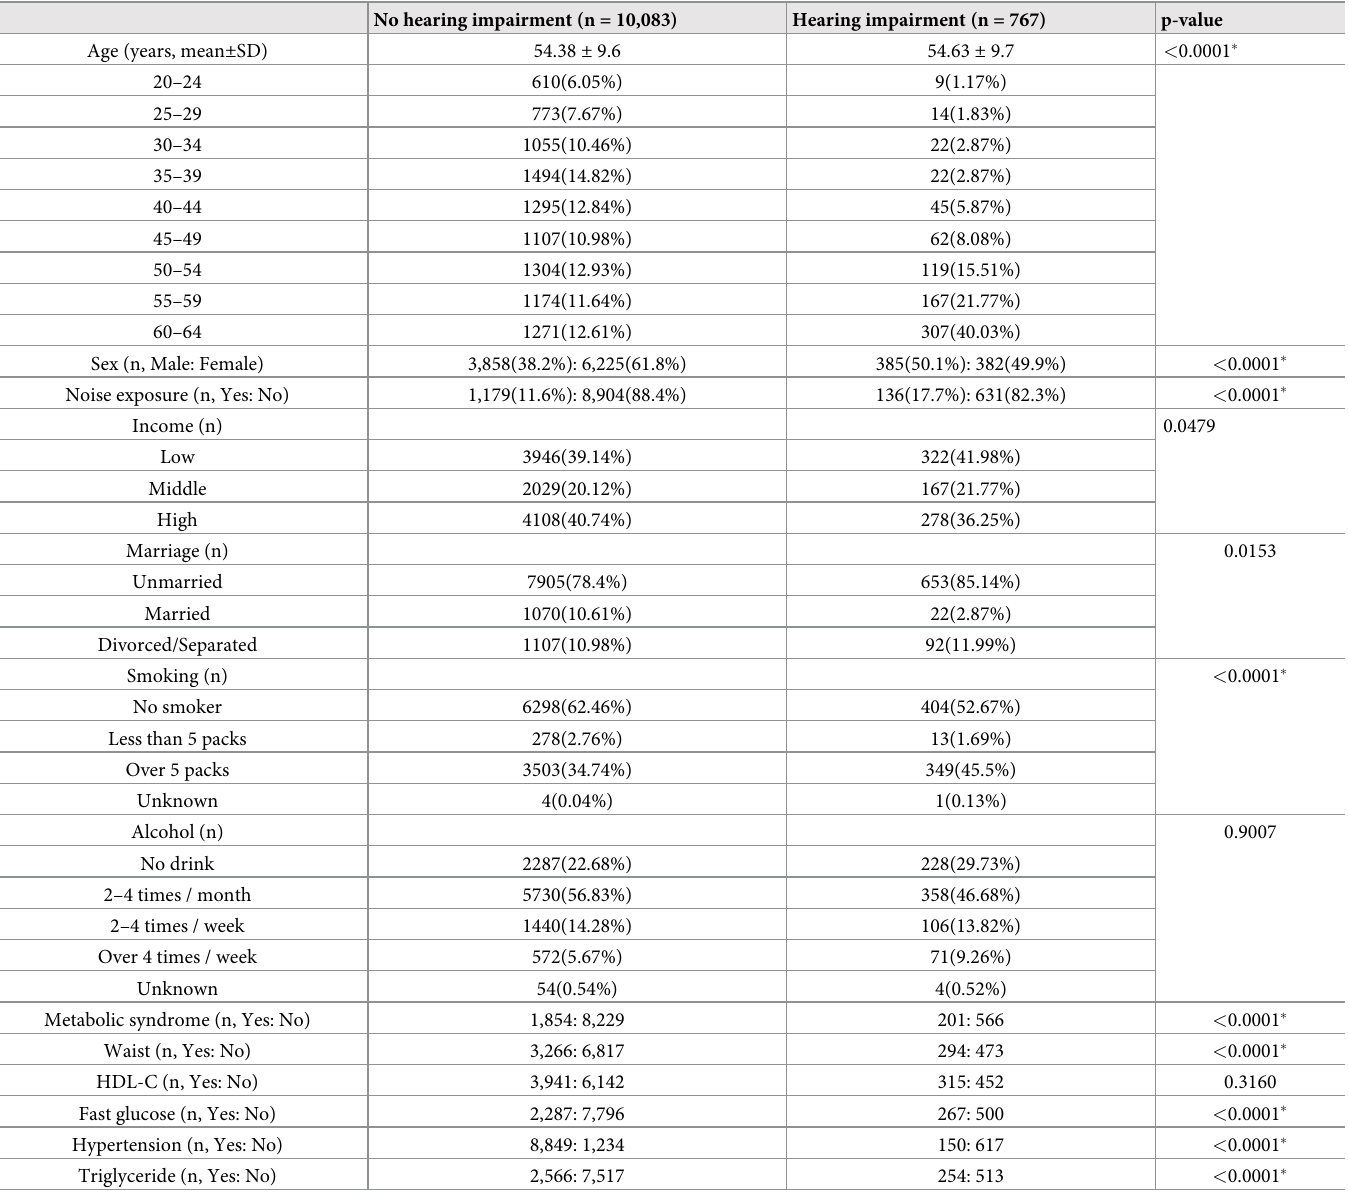
Table 1. Comparisons of demographic and clinical characteristics between subjects with and without hearing